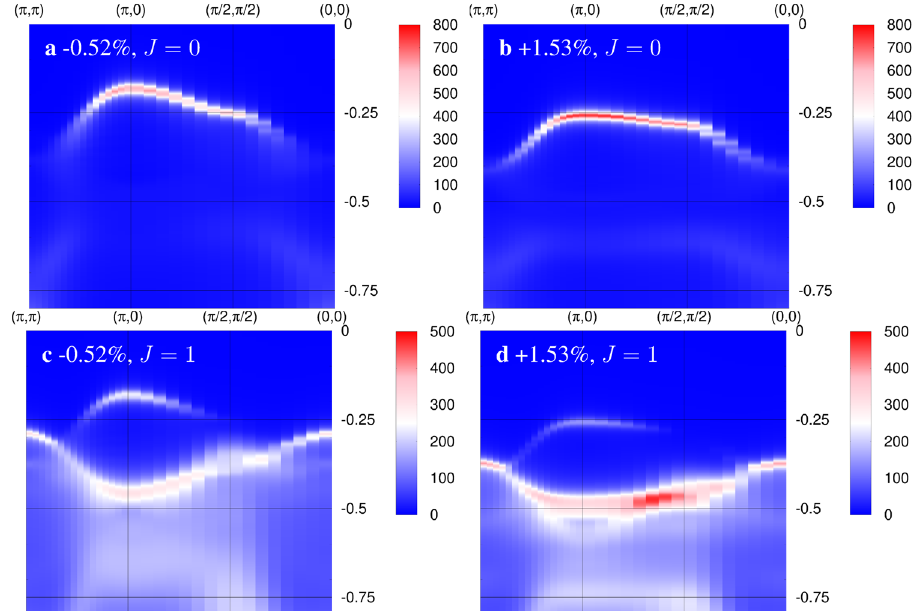
Fig. 7 Contribution of singlet J = 0 and triplet J = 1 states to the spectral function of Sr 2 IrO 4 for various strain values. Singlet J = 0 contribution to the ARPES spectral function: a LSAT, − 0.52% (compressive strain), b GSO, + 1.53% (tensile strain); Triplet J = 1 contribution to the ARPES spectral function: c LSAT, − 0.52% (compressive strain), d GSO, + 1.53% (tensile strain). The horizontal axis is the 2D crystal momentum. The vertical axis is the energy (eV), where zero energy represents the Fermi